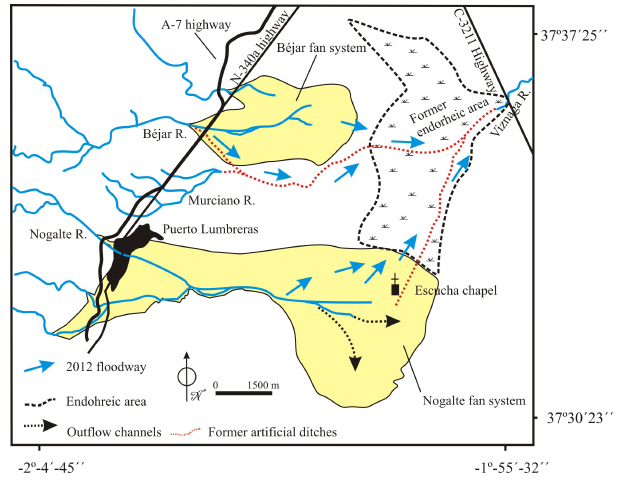
Figure 8. Evolution of the 2012 flood from the medium Nogalte fan and the Béjar stream (blue arrows) following former artificial ditches through Viznaga Rambla, flooding endorheic areas at the end of the Nogalte distal fan (Escucha Chapel) and confined areas around the C-3211